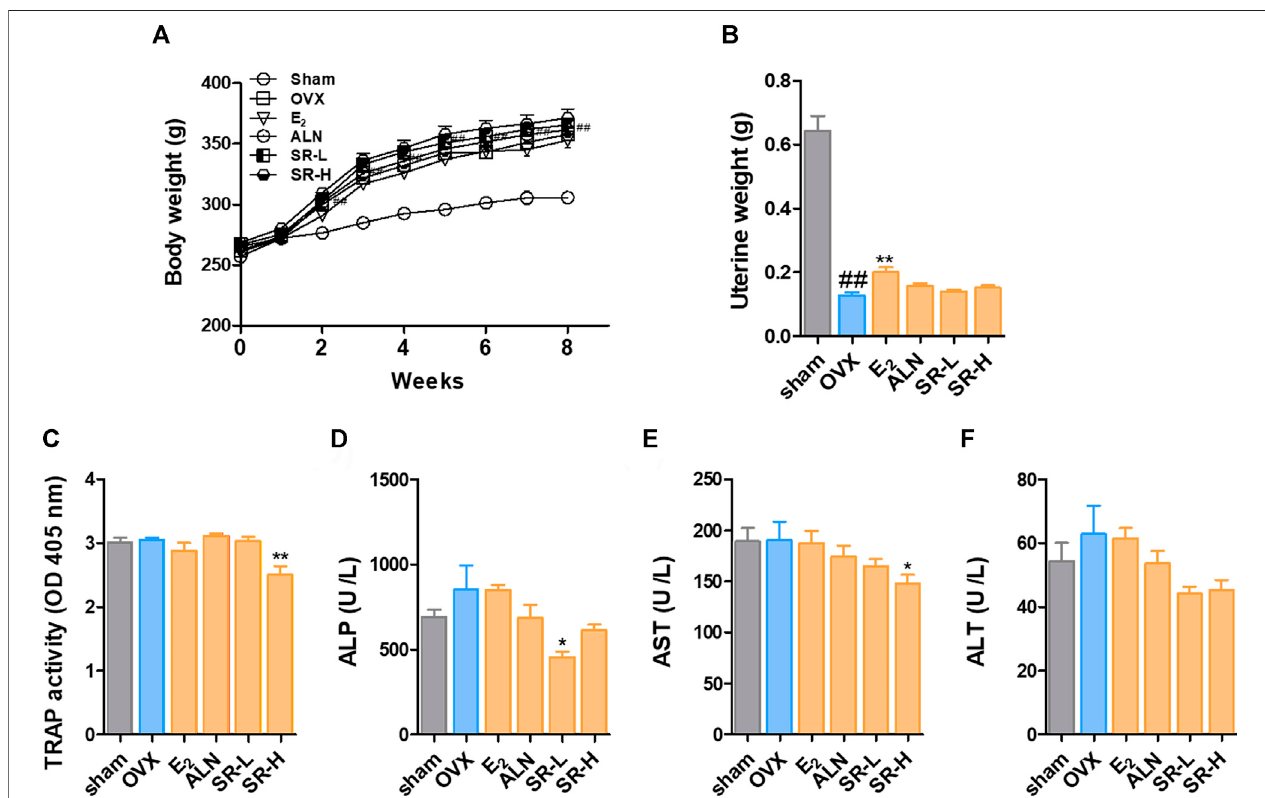
FIGURE7| Change inbody weight and serum levels ofTRAP,ALP, ASTand ALTin theOVX model. (A) Bodyweightwasmeasured onceaweek for8 weeks. (B) The uterine weight was measured after sacri fi ce. The serum levels of (C) TRAP, (D) ALP, (E) AST, and (F) ALT were measured using an ELISA reader. The results are presented as the mean ± SEM of each experimental group ( n (cid:2) 8). Statistical analysis was performed using one-way ANOVA followed by Dunnett ’ s post hoc test. # p < 0.05, ## p < 0.01 vs. the normal group (sham-operation group); * p < 0.05, ** p < 0.01 vs. the control group (OVX-induced